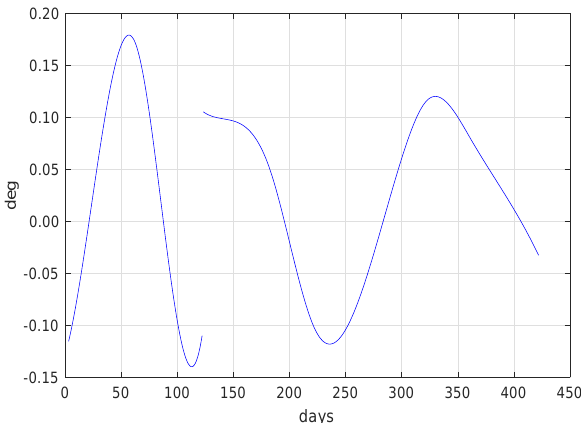
Figure 19. Moving RMS of the residuals of the modelled positions in the East component for the East point (red line) and the West point (blue line)